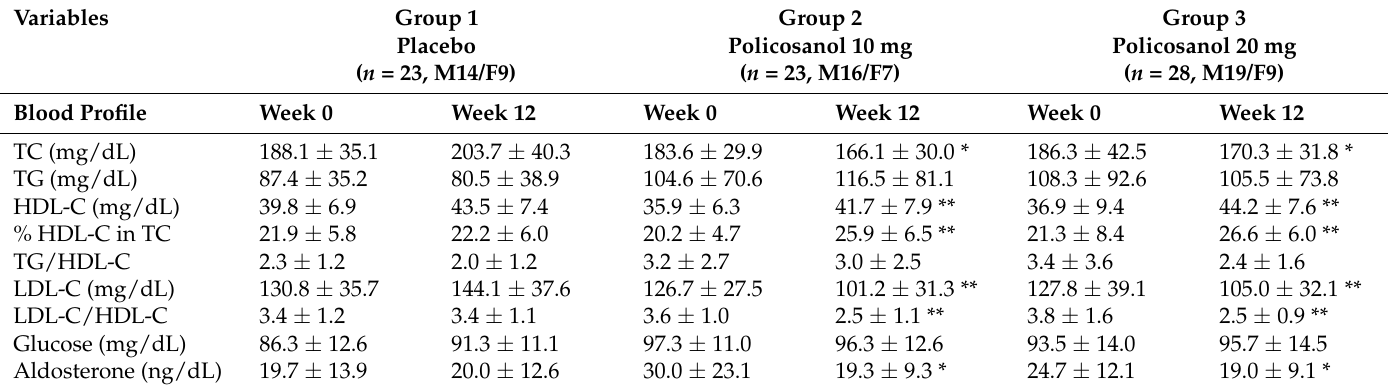
Table 4. Change of serum lipid profile after 12-week policosanol